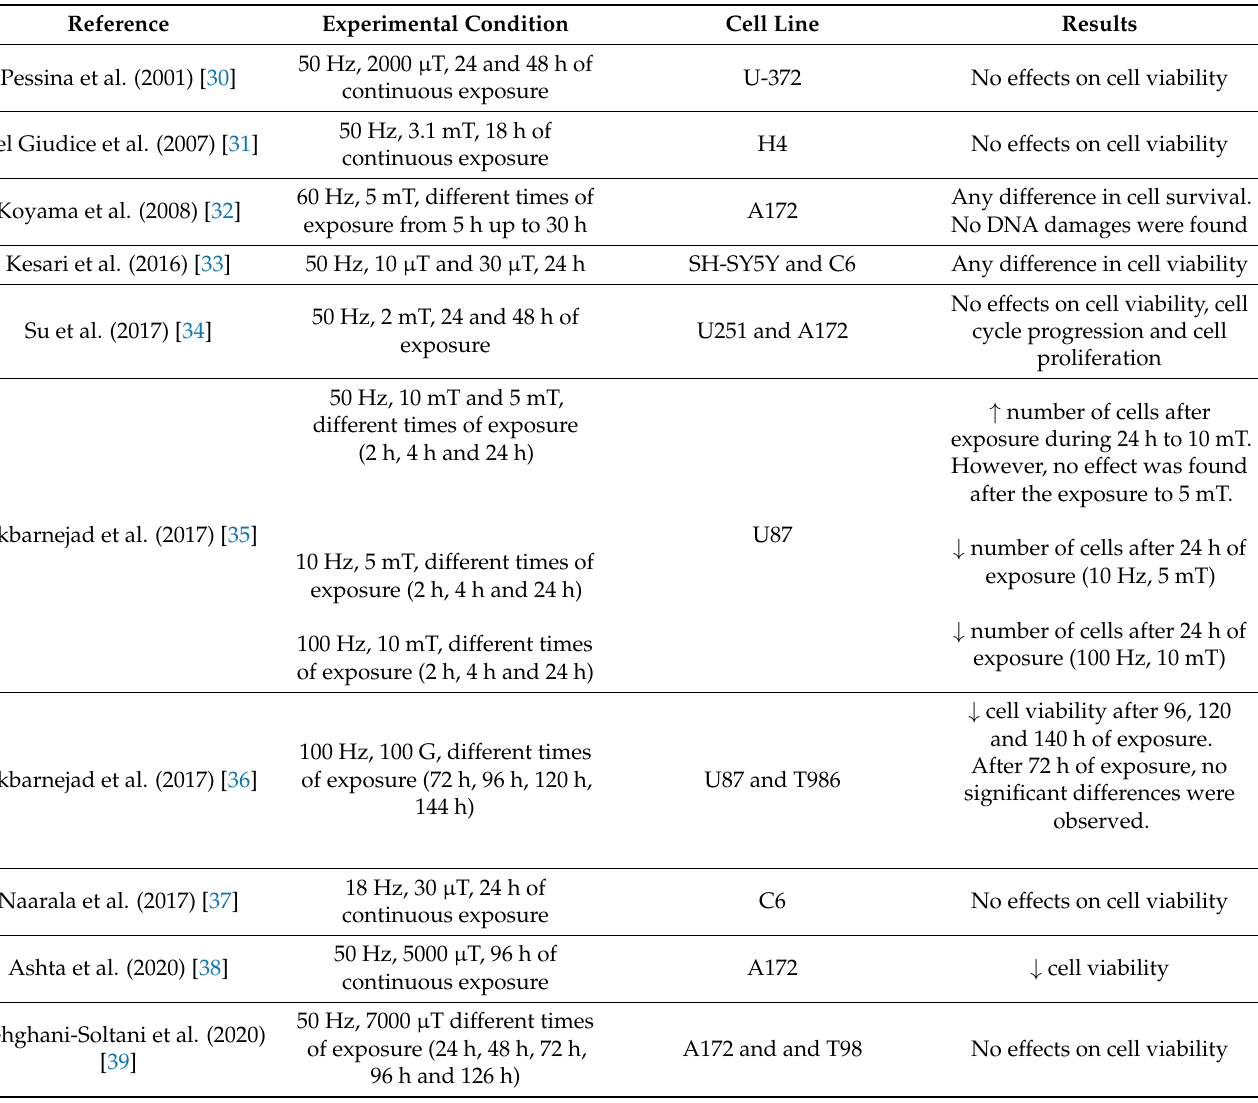
Table 2. Summary of results obtained in different in vitro studies with neuroblastoma and glioblastoma cells lines exposed to ELFs